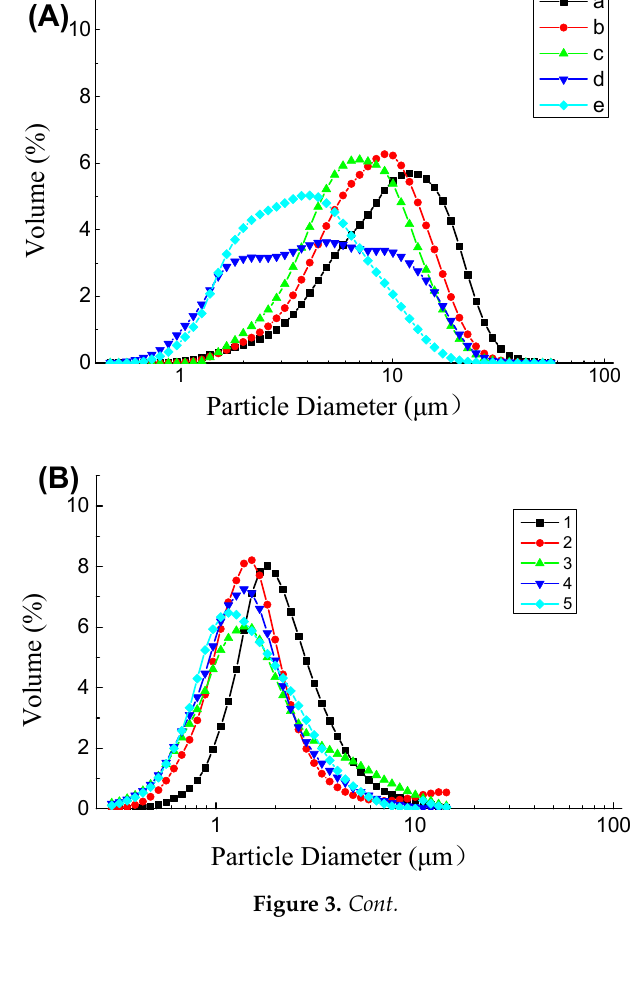
Figure 4. Microphotographs of the primary emulsions directly reflected the sizes of the oil droplets in the emulsions, which corroborated the decreasing mean particle diameter.